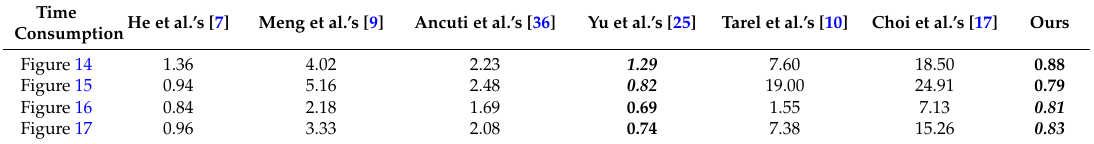
Table 5. Comparison of time consumption for the dehazing results obtained via different